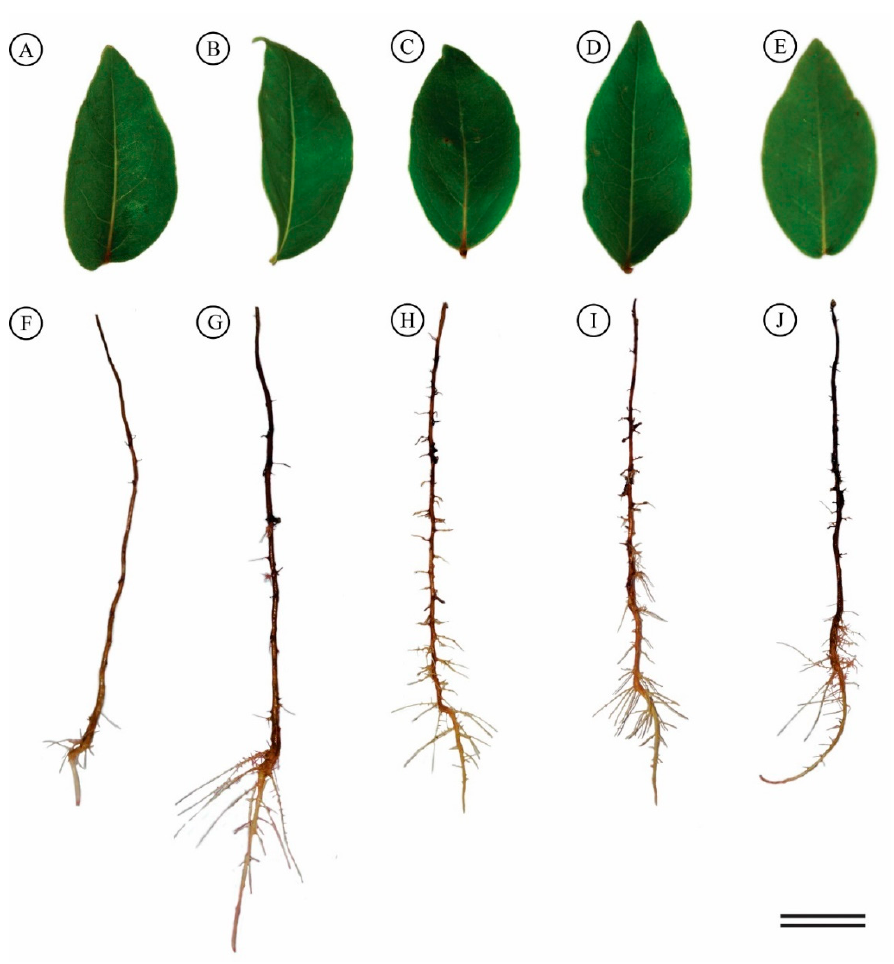
Figure 2. Visual appearance of Eugenia dysenterica leaves and roots after 20 days exposure to various Al concentrations: ( A – F ) control, ( B – G ) 200, ( C – H ) 400, ( D – I ) 600 and ( E – J ) 800 μ mol L − 1 AL. Bar = 2